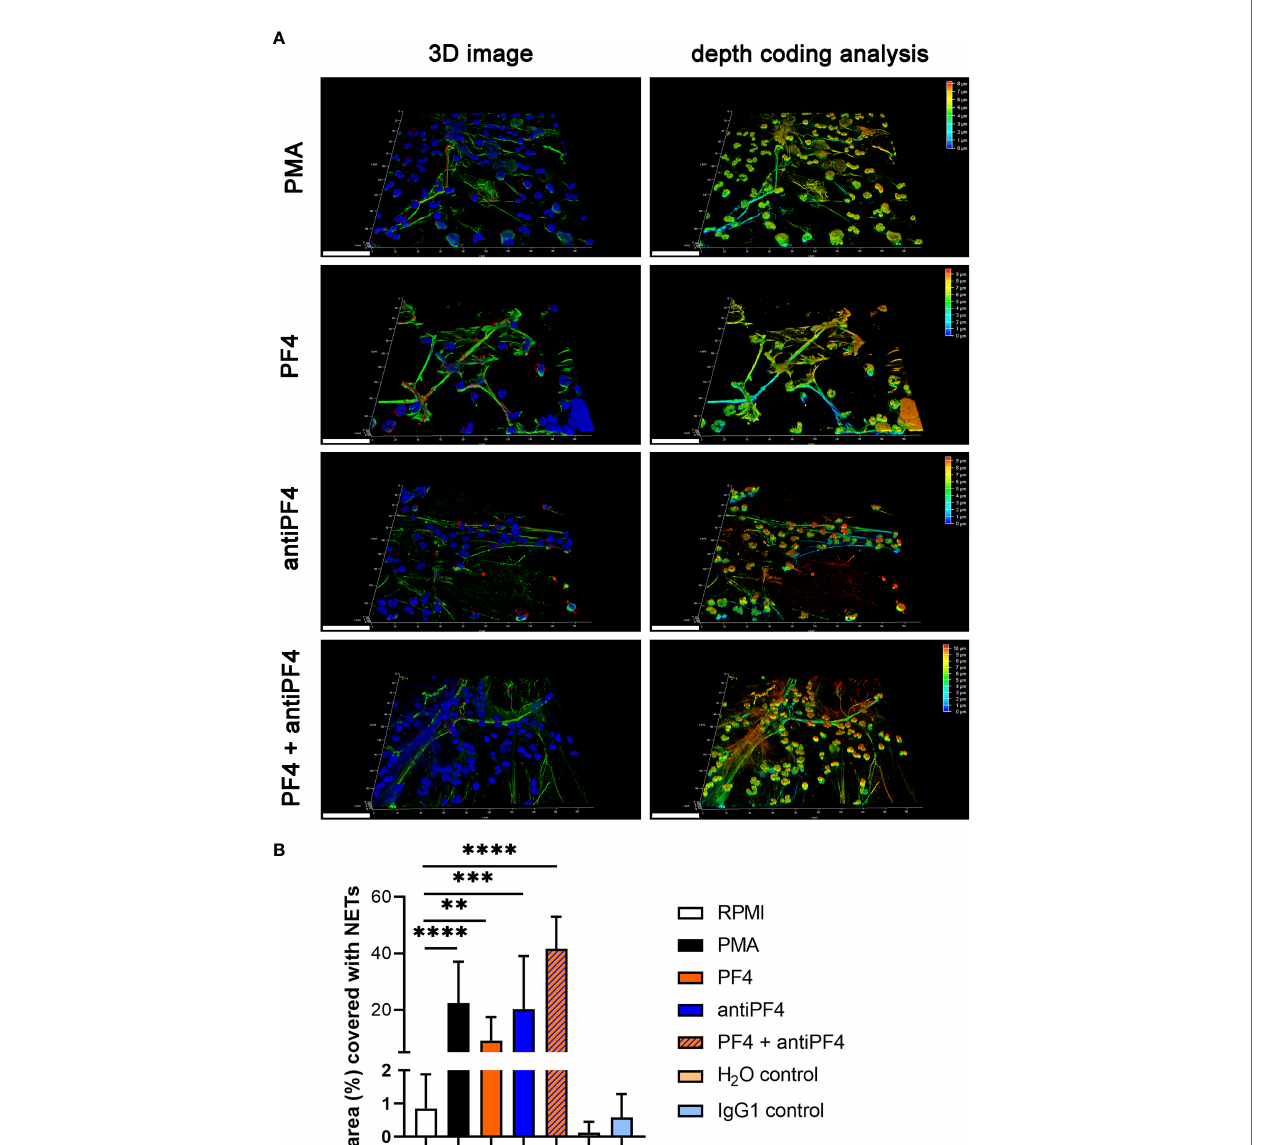
FIGURE 3 | PF4 and antiPF4 are potential NET inducer forming compact NETs. Human blood-derived neutrophils release NETs after 2 h incubation in response to PF4 and antiPF4. NETs were detected by confocal immuno fl uorescence microscopy. The settings were adjusted to a respective isotype control. (A) Representative 3D reconstructions of z-stacks are presented, showing extracellular DNA- fi bers positive for DNA/histone-1 complex (green) and myeloperoxidase (red), (Scale bar = 50 µm). Images were constructed with LAS X 3D Version 3.1.0 software (Leica): PMA = 8.09 µm consisting of 49 sections; PF4 = 9.57 µm consisting of 58 sections; antiPF4 = 9.40 µm consisting of 57 sections; PF4 and antiPF4 = 10.41 µm consisting of 63 sections. Out of this 3D volume a depth coding analysis was conducted and is presented with a depth coding scale bar. (B) In each experiment and for each sample, six randomly taken pictures from two individual slides were analyzed for NET quanti fi cation. The area covered with NETs was measured and used for statistic. In one experiment the internal controls H 2 O and mouse IgG1 were included as control for PF4 (dissolved in H 2 O) and antiPF4 (mouse IgG1 anti human PF4). Data were analyzed with one-tailed unpaired Student ’ s t-Test calculated always to negative control (RPMI) (**p < 0.01, ***p < 0.001 and ****p < 0.0001). Data are presented with mean ±